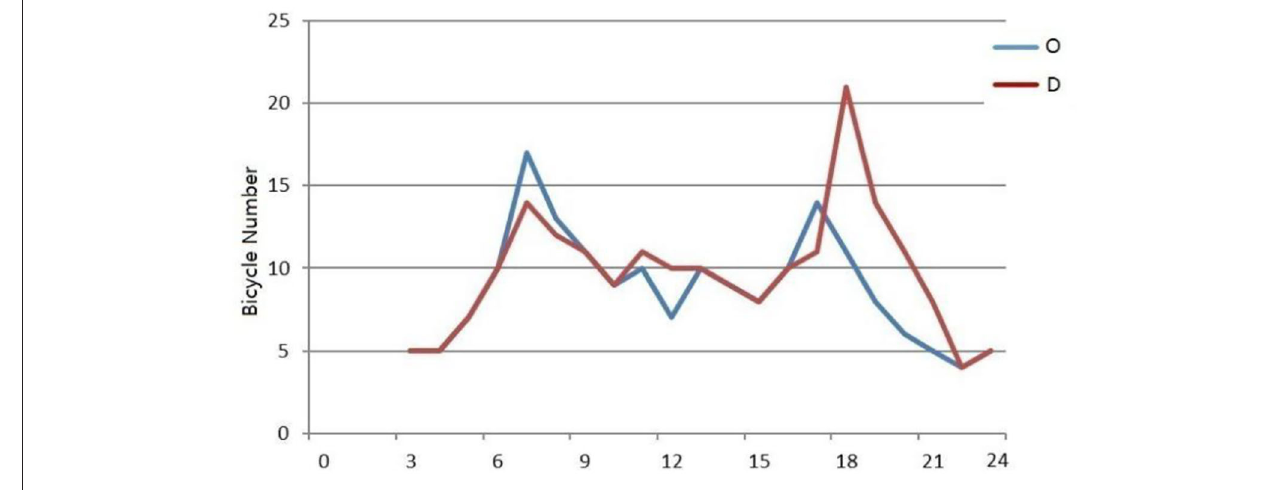
FIGURE 7 | Prediction of bicycle OD quantity in Huaxincheng.